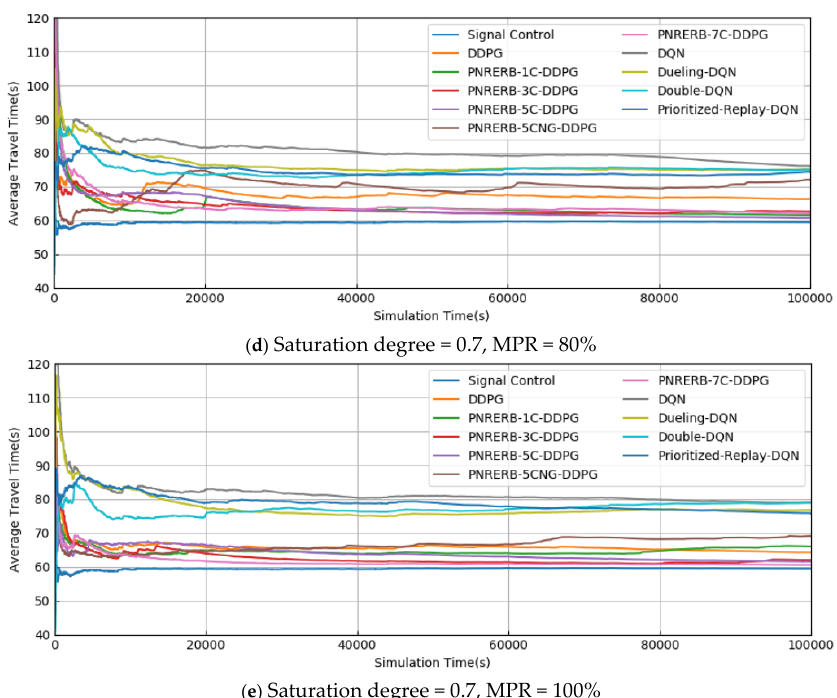
Figure 6. ATT for different CAV penetration rates under a saturation degree of 0.7.